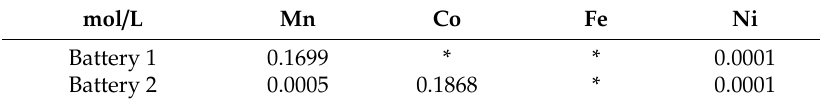
Table 4. Chemical composition of electrolyte solutions from the recycled Li-ion battery cathode. mol /